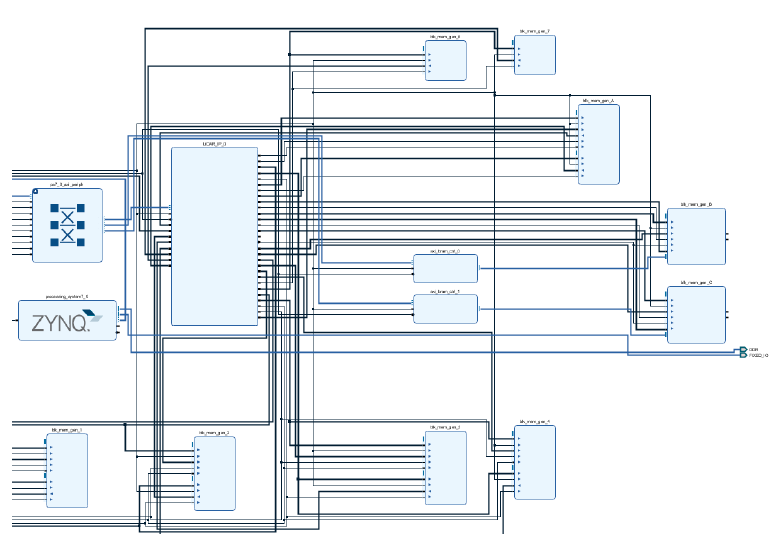
Figure 9. DDC FMCW LiDAR System Implemented Using VIVADO.